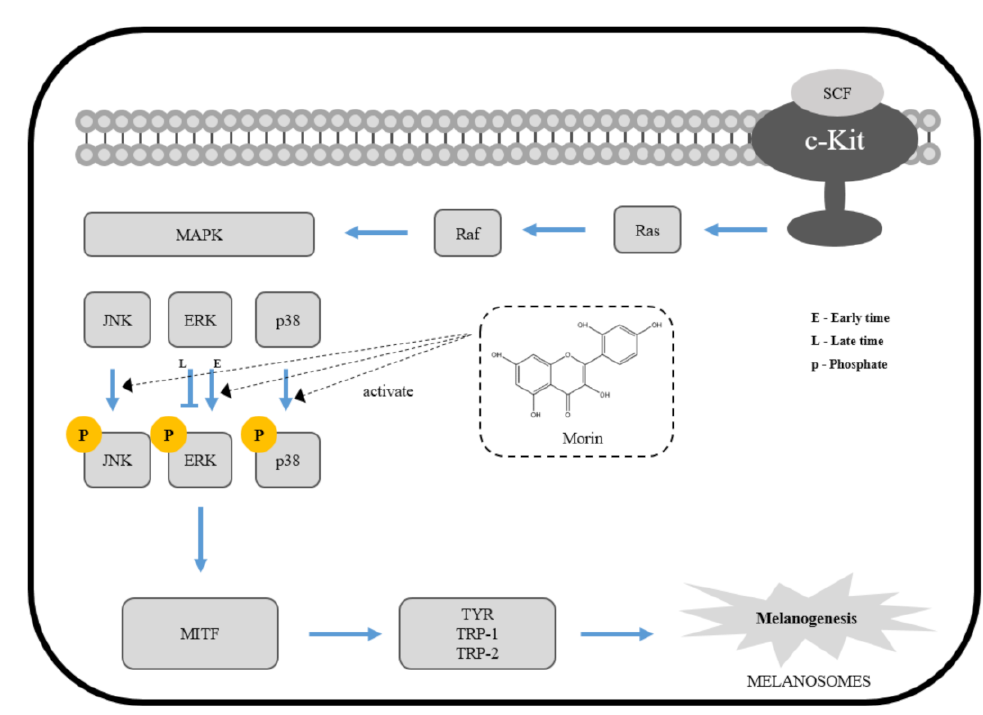
Figure 7. The mechanism of morin-induced melanogenesis in B16F10 mouse melanoma